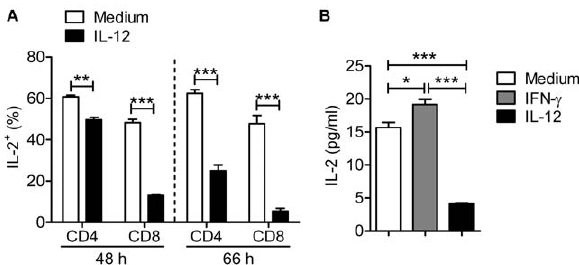
Figure 8. IL-12 inhibits IL-2 expression by T cells. Lymphocytes were prepared from naı¨ve Foxp3 gfp mice and treated with anti-CD3 mAb and IL-12 or IFN- c . (A). The fraction of CD4 and CD8 T cells expressing IL-2 was diminished after 48 and 66 hr. Data are from 3–5 independent experiments. (B) Levels of IL-2, measured by ELISA, were reduced in IL-12 but not IFN- c -treated cultures at 48 hr. Data are representative of 2 independent experiments performed in triplicate for stimulation, and each sample plated in duplicate for ELISA. * P , 0.05,